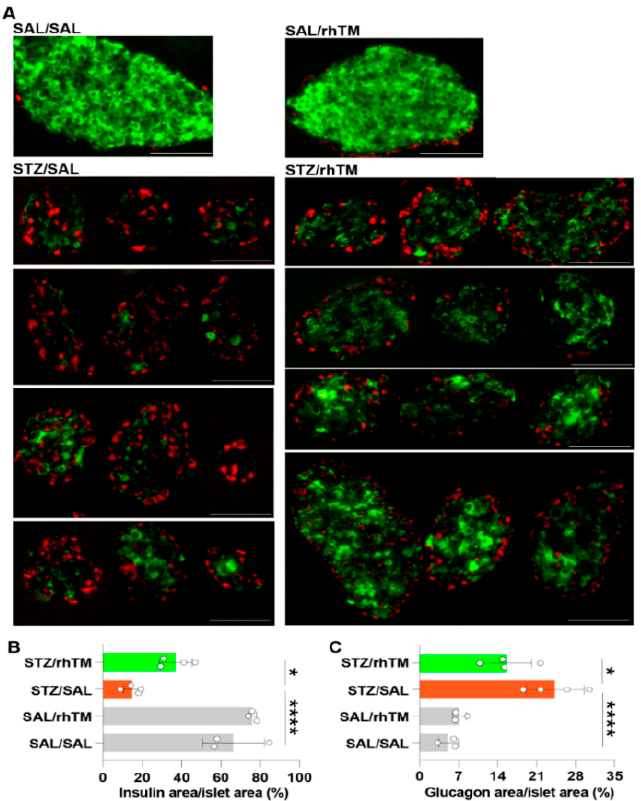
Figure 3. Treatment of diabetic mice with recombinant human thrombomodulin increased the insu- lin-producing area. ( A ) Immunofluorescence staining of β -cells (green) and α -cells (red) in each mouse group. Scale bars indicate 50 µm. ( B , C ) The areas of β -cells and α -cells were measured using the WinROOF image processing software. Data are the mean ± S.D. Statistical analysis by ANOVA